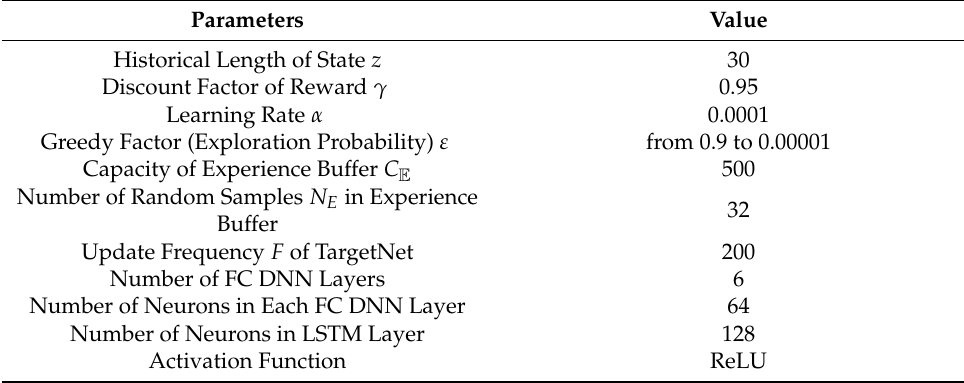
Table 1. The hyperparameter settings of